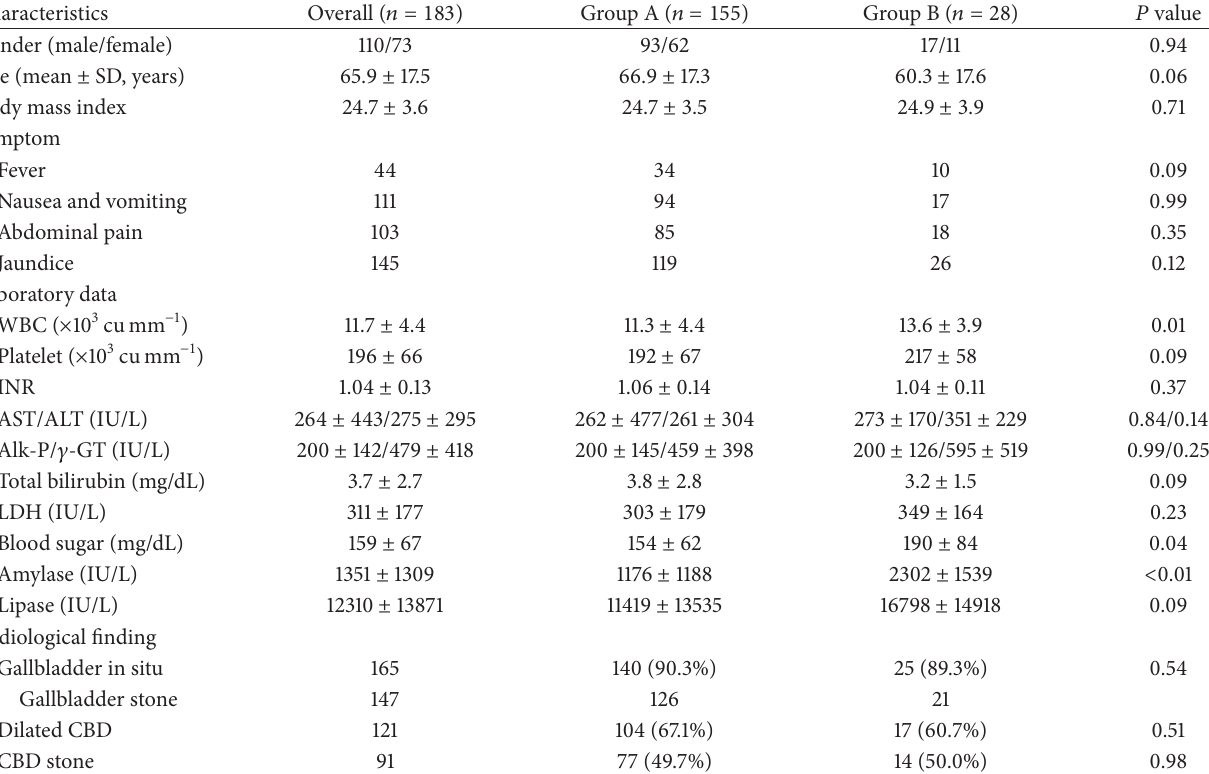
Table 1: Characteristics of overall patients and comparisons between patients with mild (A) and severe (B) degree of acute biliary